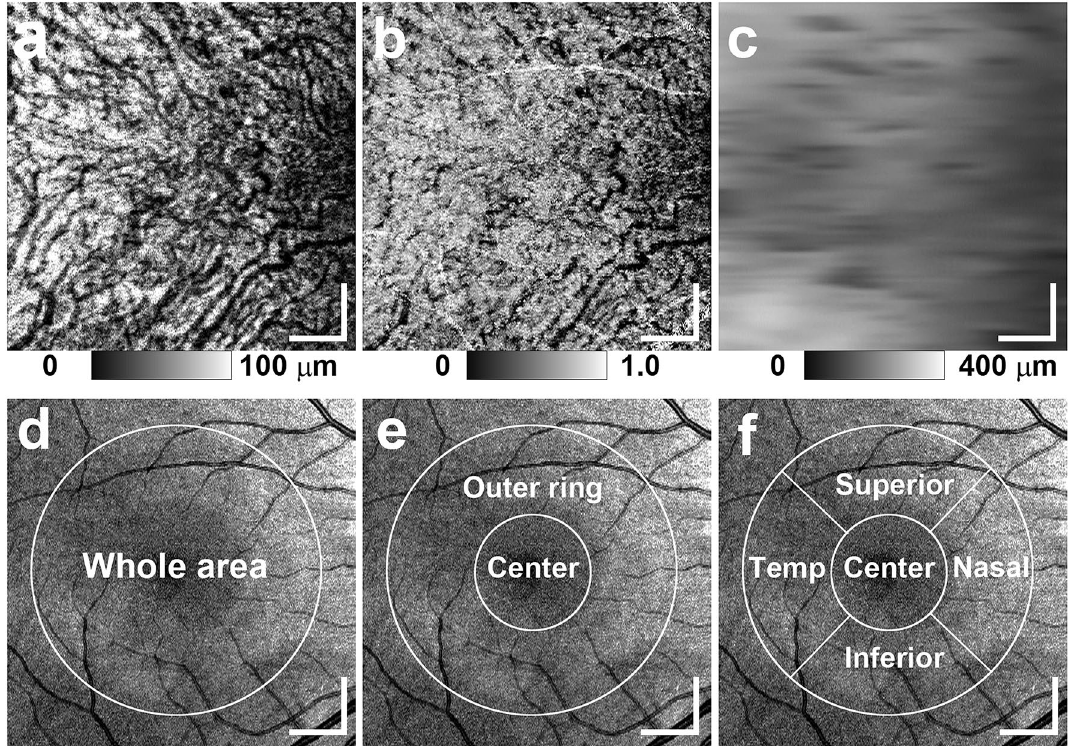
Figure 2. En-face PS-OCT images of the eye in Fig. 1. ( a ) Thickness map of melanin-containing tissue in the choroid, ( b ) choroidal melanin occupancy rate map, and ( c ) choroidal thickness map were calculated using volumetric data from PS-OCT. ( d – f ) En-face projection images of standard OCT. ( d ) The whole area was defined as the inner area of the outer circle. ( e ) The outer ring area was defined as the area between the outer circle and the inner circle, and the center area was defined as the inner area of the inner circle. ( f ) The outer ring area was divided into superior, inferior, temporal (Temp), and nasal areas. The scale bars represent 1.0 mm × 1.0